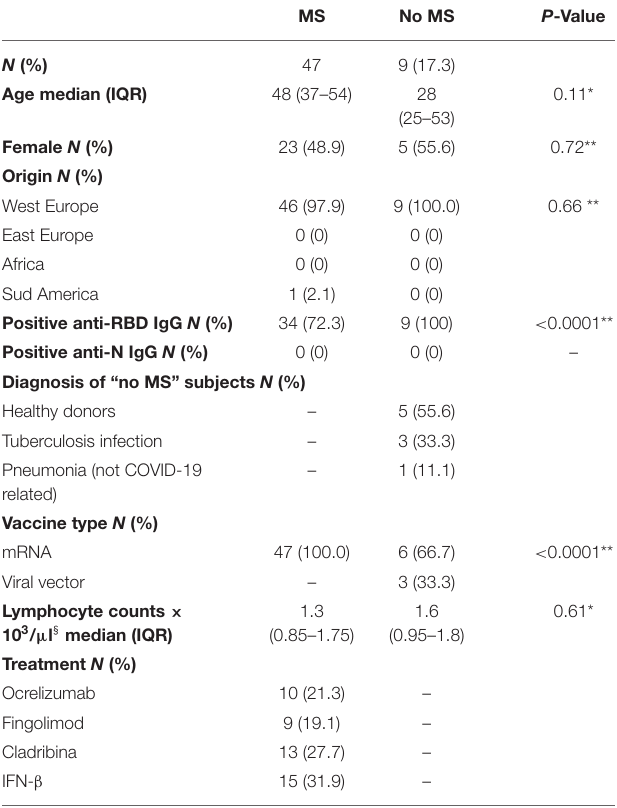
TABLE 1 | Demographical and clinical characteristics of the enrolled subjects.